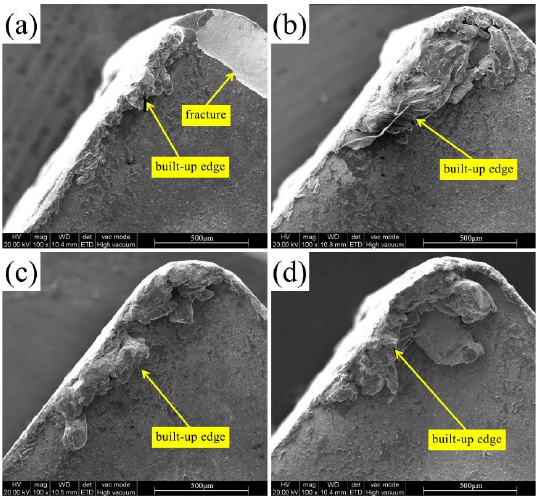
Figure 15. Wear of the rake face using uncoated inserts: ( a ) CT; ( b ) 0.42 A/mm 2 ; ( c ) 0.57 A/mm 2 ; and ( d ) 0.90 A/mm 2 .